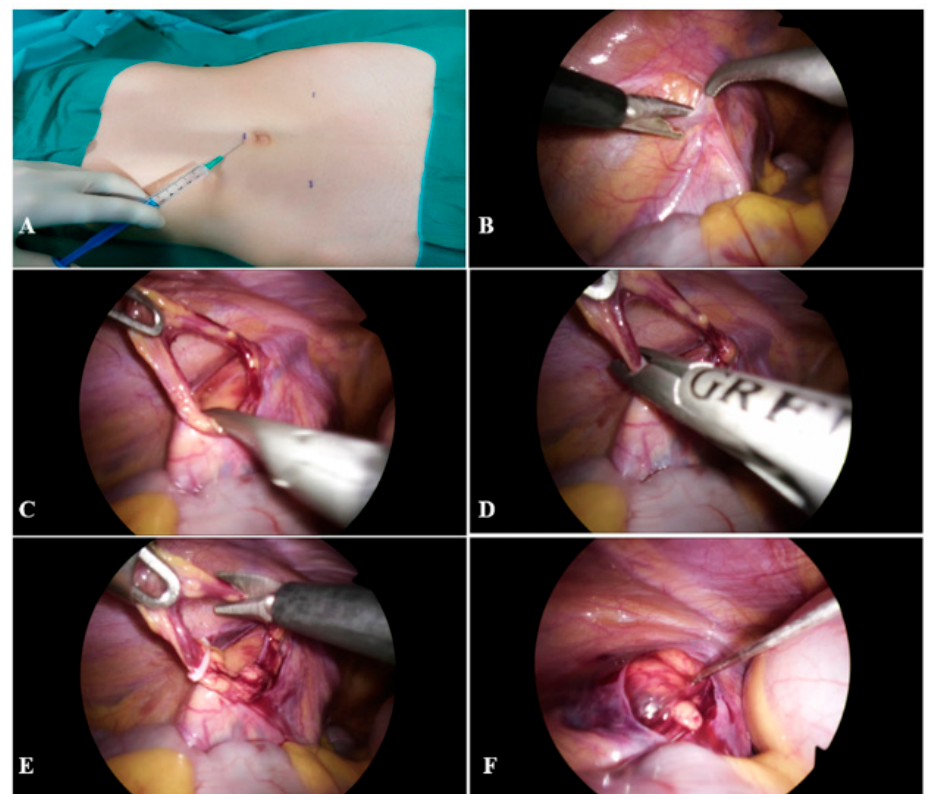
Figure 2. Laparoscopic varicocelectomy: ( A )—Subcutaneous instillation of local anesthetic at trocar sites; ( B )—Identification of spermatic vessels and opening of peritoneum using laparoscopic scissors; ( C )—Spermatic blood vessels preparation; ( D )—Placement of nonabsorbable polymeric ligating clips on the spermatic blood vessels; ( E )—Resection of spermatic blood vessels; ( F )—Instillation of local anesthetic below and around the site of the peritoneal defect.